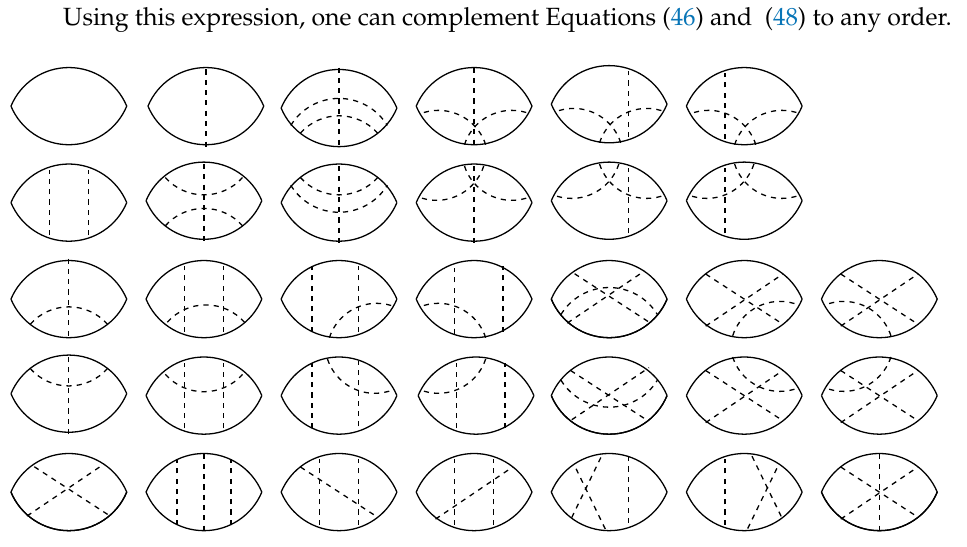
Figure 5. Perturbative processes contributing to the dressing of the two-particles propagator up to the third order in disorder strength. Solid lines denote the fully dressed Wegner’s propagators and the dashed lines denote the disorder